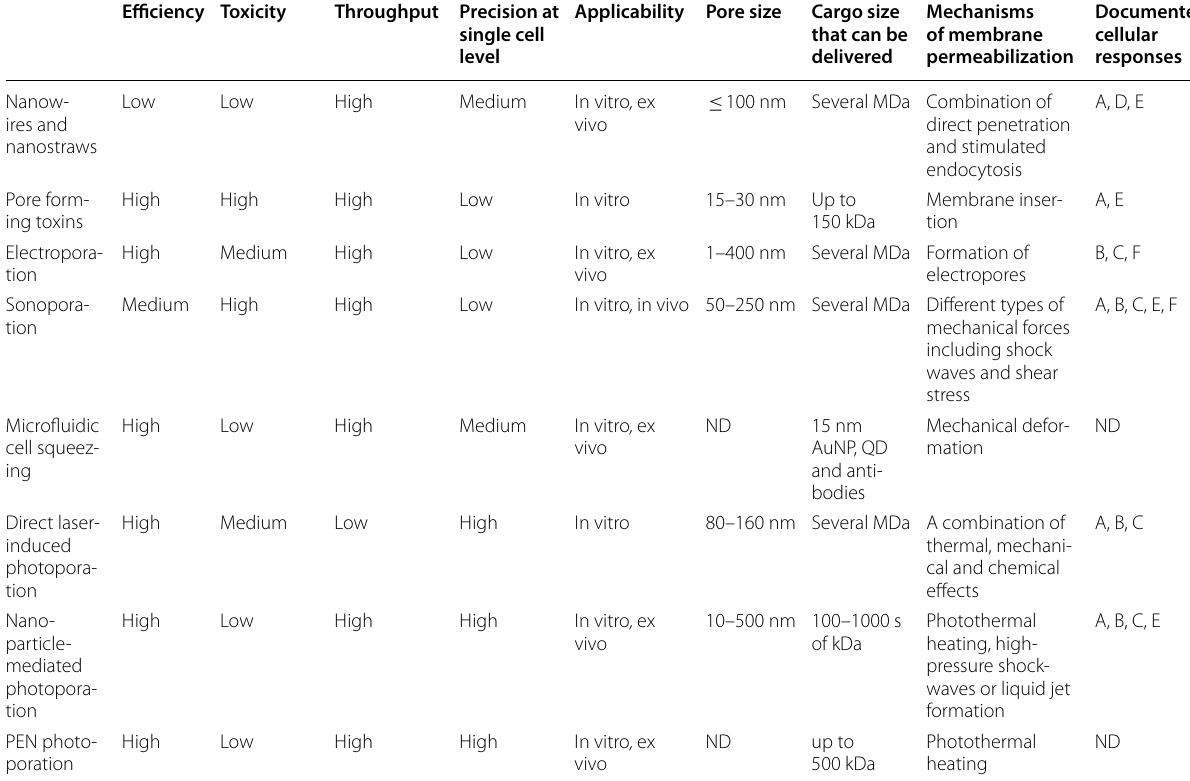
A, ion fluxes; B, cytoskeletal remodeling; C, morphological changes; D, DNA damage; E, ER stress; F, delay in cell cycle progression; ND, Not